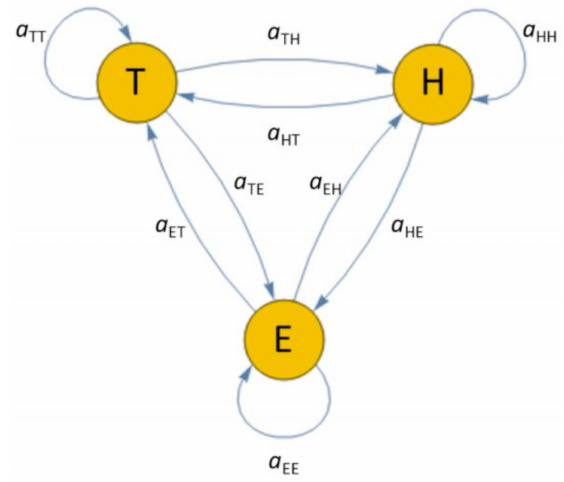
Figure 2. State diagram of the Hidden Markov Model (HMM) used to generate long-term activity data.